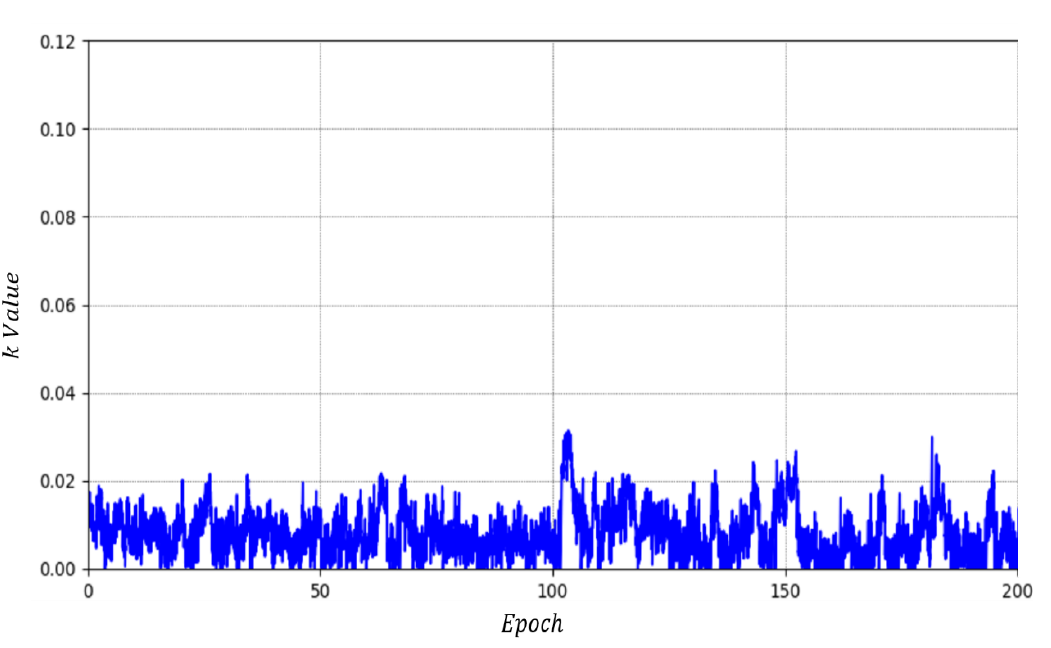
Figure A4. Results of convergence measurement for the LSUN bedroom dataset.